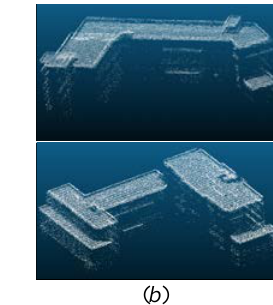
Figure 8. Airborne LiDAR data of the test area. (a) is part of the study area. (b) is the point clouds for two buildings. Top: the student dorm, bottom: the instruction building.